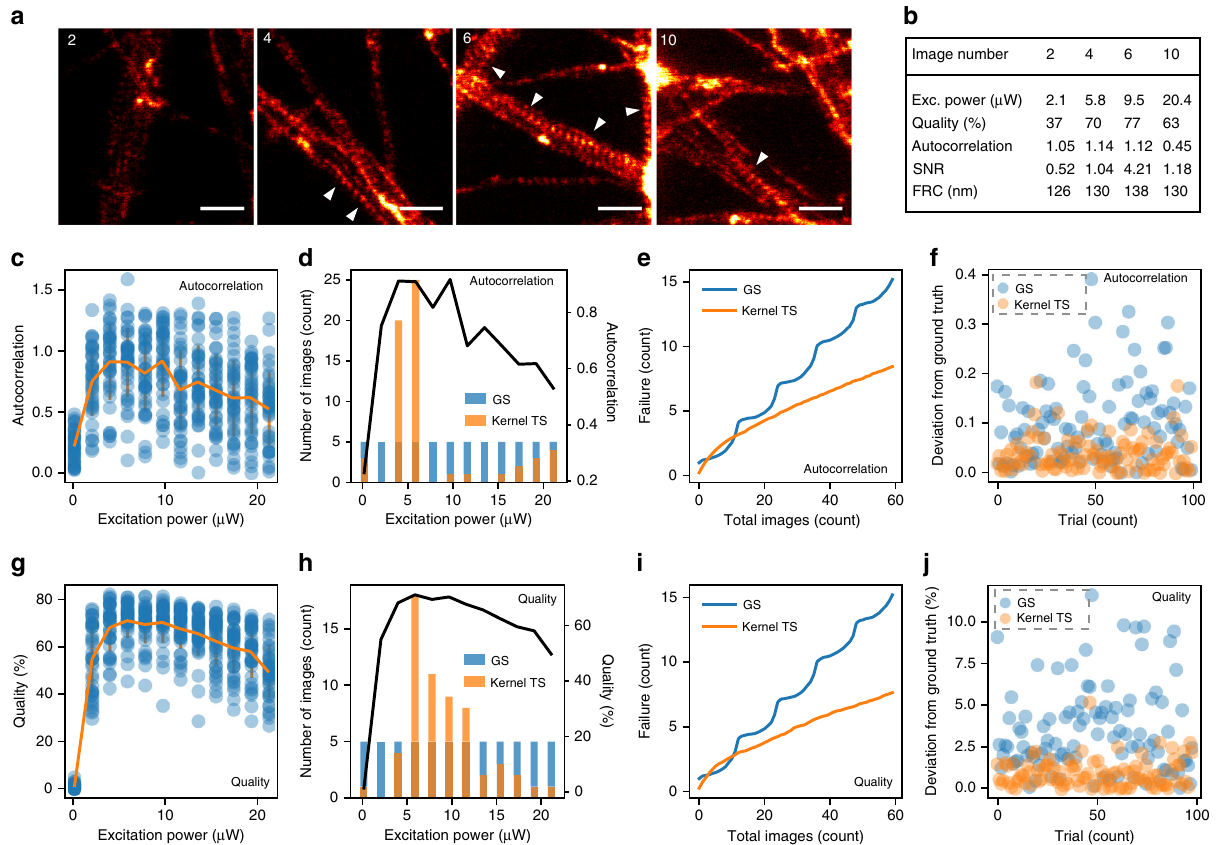
Fig. 1 Replay experiment of single-objective optimization. a Selected images of actin, labeled with phalloidin-STAR635 in fi xed cultured hippocampal neurons, from the fi rst ten images of the dataset at four increasing laser power values. Scale bars 1 μ m. White arrowheads: actin periodical lattice. b Comparison between the quality scores, SNR, autocorrelation of the periodical actin lattice, and FRC measurements obtained for the images shown in a and acquired at the indicated excitation power. c , g Autocorrelation ( c ) and image quality ( g ) values measured for all images of the dataset (blue dots) and average of the 39 autocorrelation ( c ) or quality ( g ) values per excitation power (orange line). d , h Distribution of the selected excitation power for 60 images obtained in one replay trial for both GS and Kernel TS when evaluating the autocorrelation ( d ) or the image quality ( h ). The black line indicates the averaged functions (orange line in c and g ) for autocorrelation and for image quality. e , i Average cumulative regret of imaging failures (not detecting the actin periodical lattice) when optimizing the autocorrelation ( e ) or image quality ( i ). Note that the wave pattern is due to the decreasing probability of obtaining good images as parameters move further away from the relevant region. f , j Error between the estimated and ground truth autocorrelation ( f ) or image quality ( j ) values at the excitation power that was most often selected by Kernel TS for each optimization trial. g , h Quality scores from 0 to 1